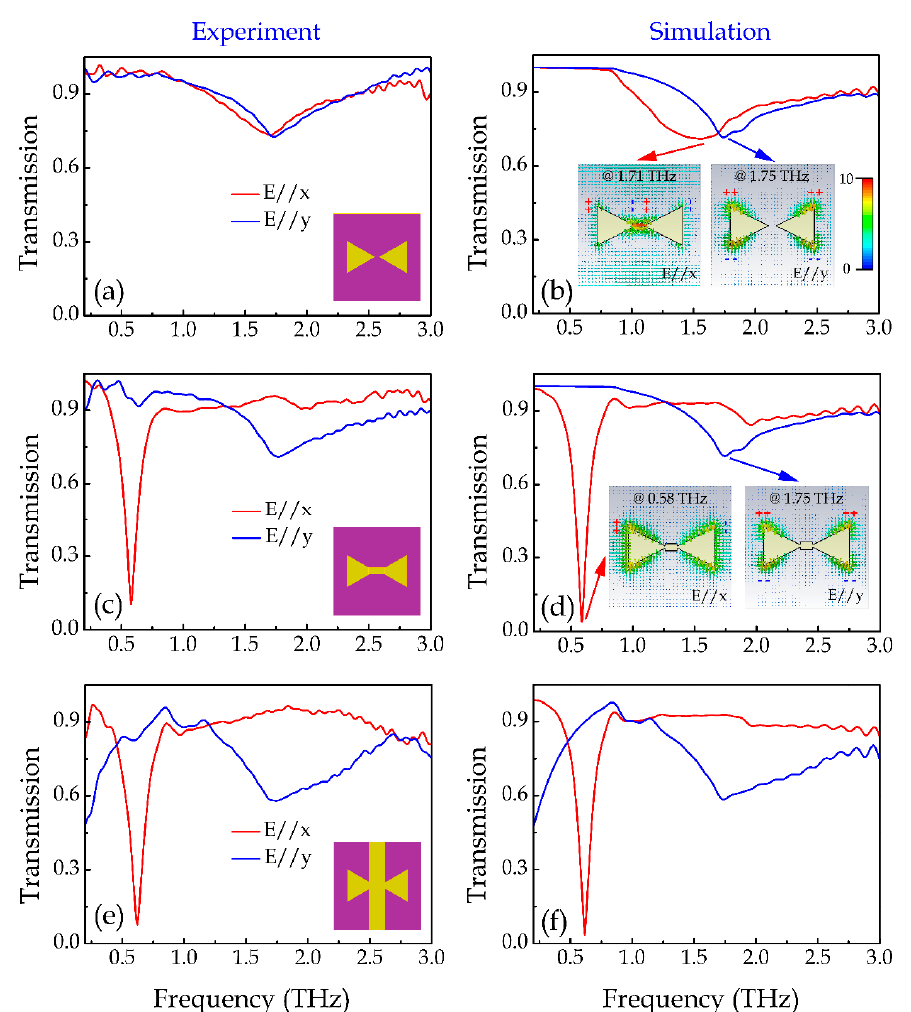
Figure 2. ( a , c , e ) Measured transmission spectra of the DTD, DTDJ and DTDS structures under x -polarized (red) and y -polarized (blue) incidences, respectively. The insets are the schematics of the corresponding structures. ( b , d , f ) Simulated transmission spectra of the DTD, DTDJ and DTDS structures under x -polarized (red) and y -polarized (blue) incidences, respectively. The insets in ( b ) and ( d ) are the simulated electric field distributions at the corresponding resonances, as indicated by the inset arrows. The “+” and “ − ” in the insets represents the sign of the accumulated charges at the ends of the corresponding structures. All the inset field distributions in ( b , d ) share a same color bar in ( b ).